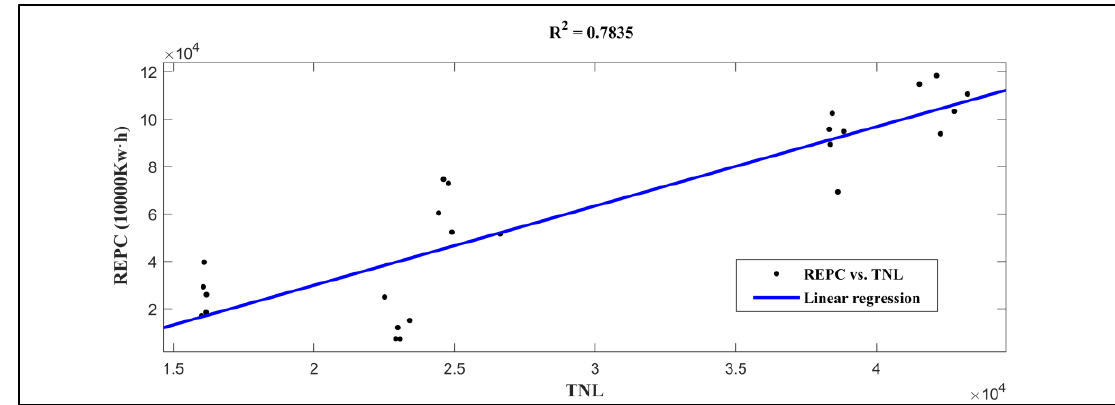
Figure 6. The results of the linear regression model.